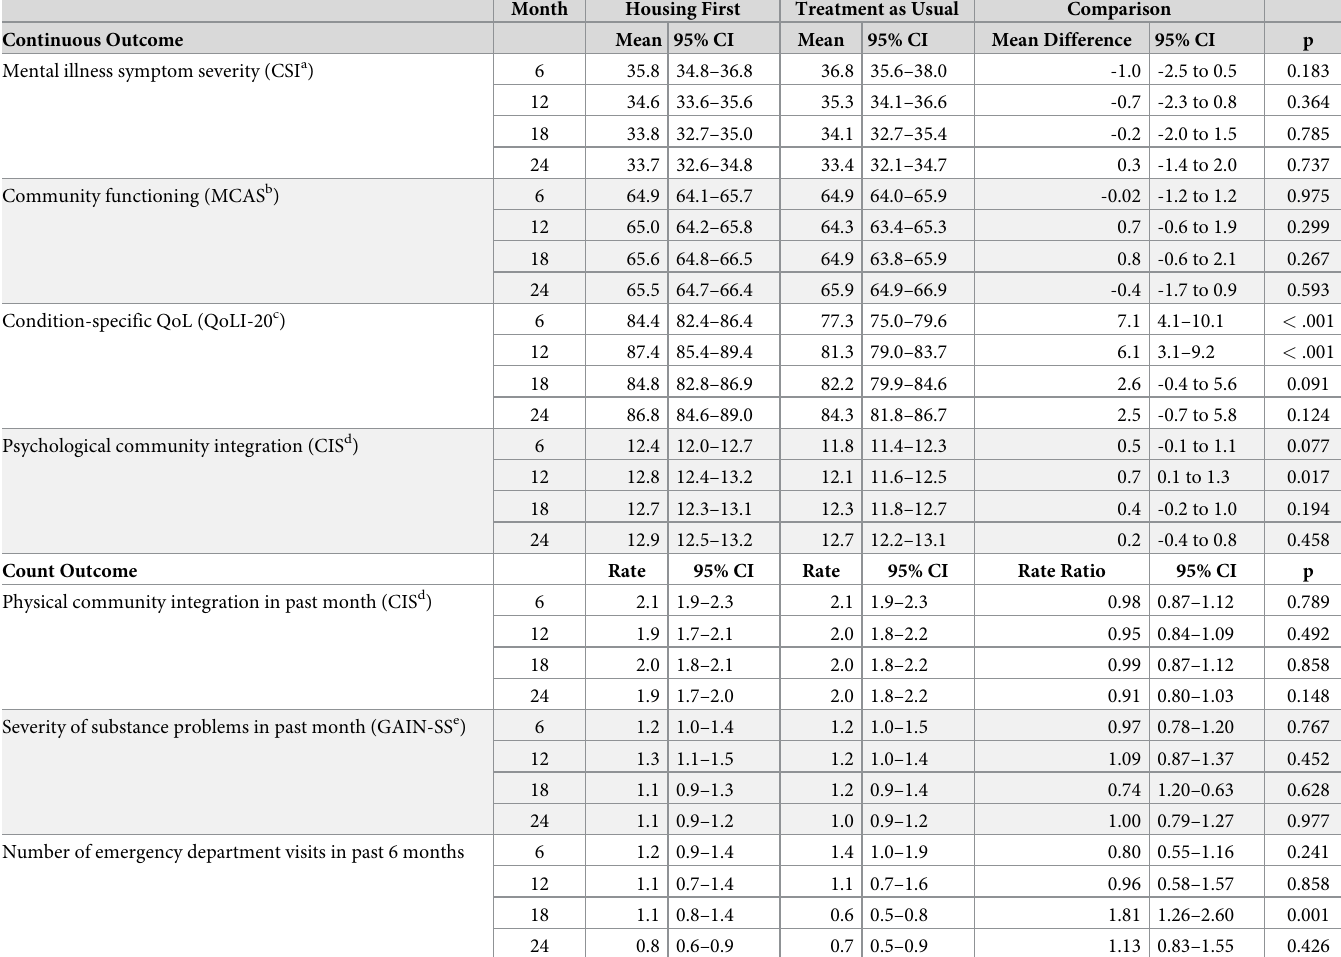
Table 3. Post-imputation pooled comparisons between housing first and treatment as usual at 6, 12, 18 and 24 months for women in the At Home/Chez Soi trial adjusted for study city, need level (ICM or ACT) and baseline outcome values f